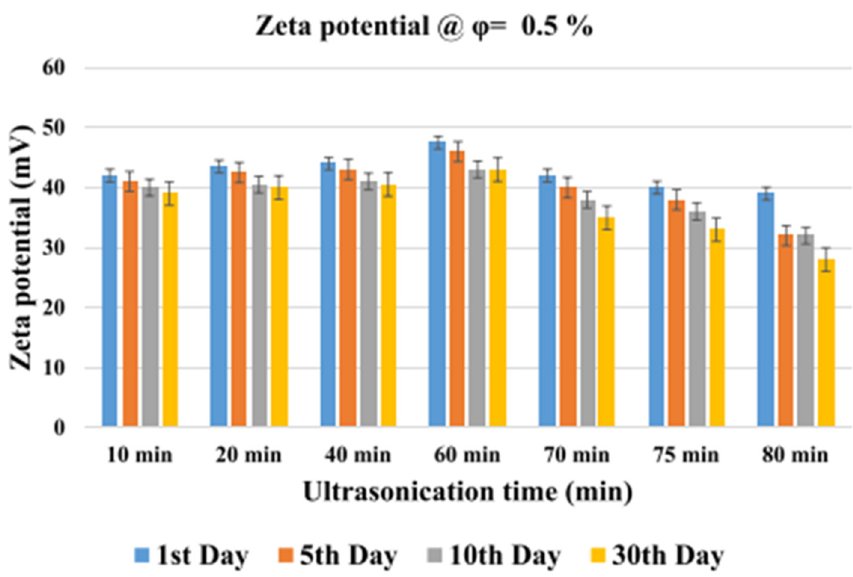
Figure 14. Effect of ultrasonication time on zeta potential of 0.5 vol% MWCNT/water NF at different storage time. Adapted from [148].